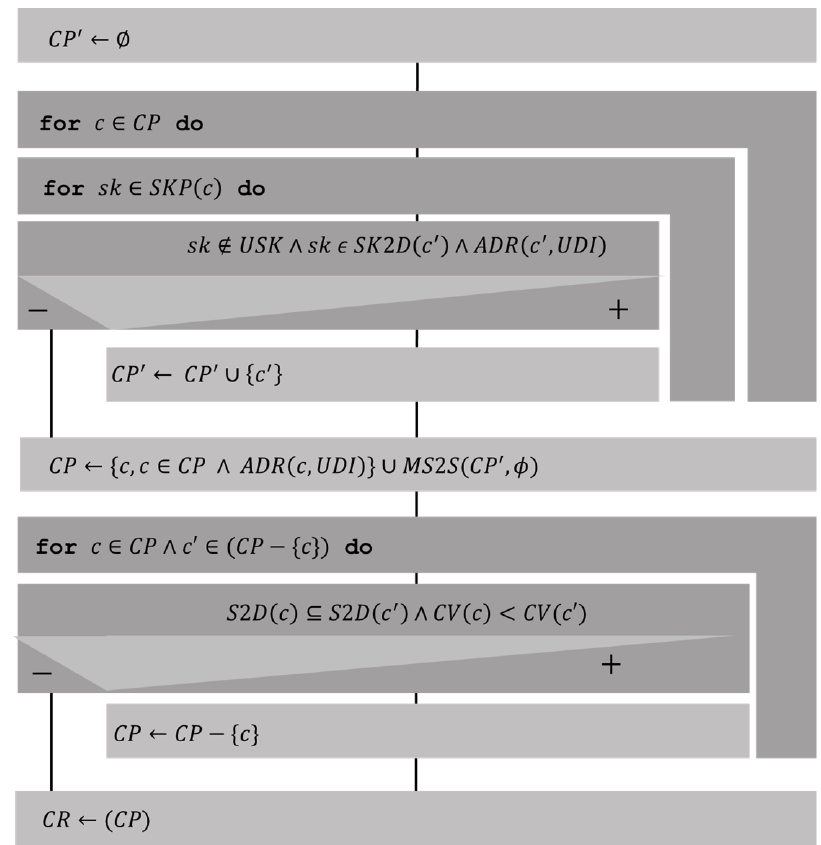
Figure 7. Final courses prediction algorithm.